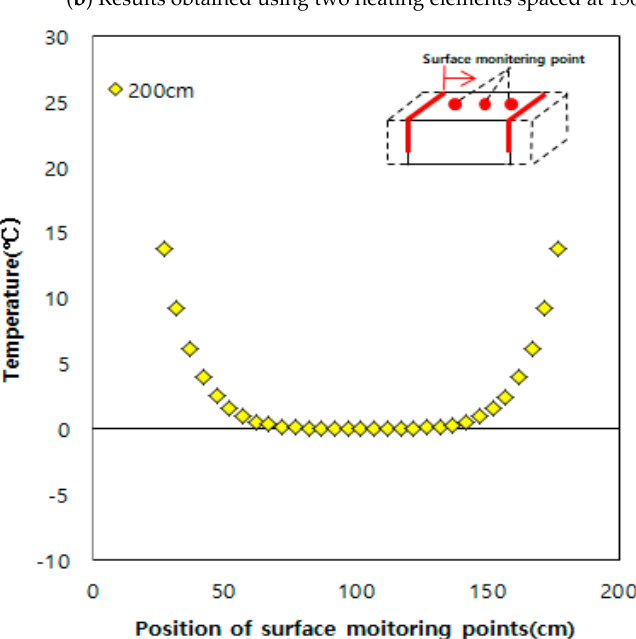
Figure 10. Numerical analysis results.